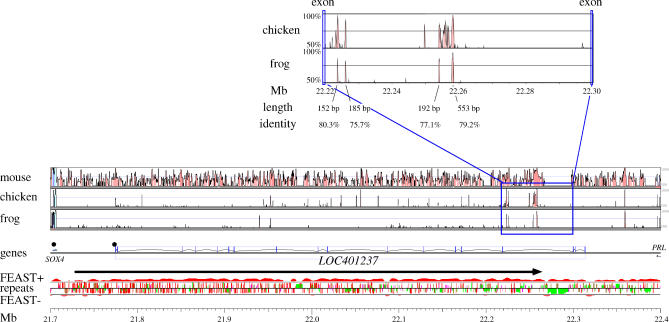
The Highest-Scoring Novel Predicted Transcript, LOC401237
VISTA and GESTALT analyses of the LOC401237 locus, showing sequence conservation with the mouse, chicken, and frog orthologous loci; the observed intron-exon structure of LOC401237 and location of neighboring genes, with black circles representing CpG islands; the integrated FEAST scores for the forward (+) and reverse (−) strands, with the black arrow representing the calculated maximal segment; the repeat distribution on both strands, with red, green, pink, and brown bars, respectively, representing Alu, MIR, LINE, and other repeats, and bar height indicating repeat age (younger repeats are taller); the megabase scale, range 21.7 to 22.4 Mb from the p telomere.Inset on top: Detail on the conserved intronic noncoding sequences, between two nonconserved exons.